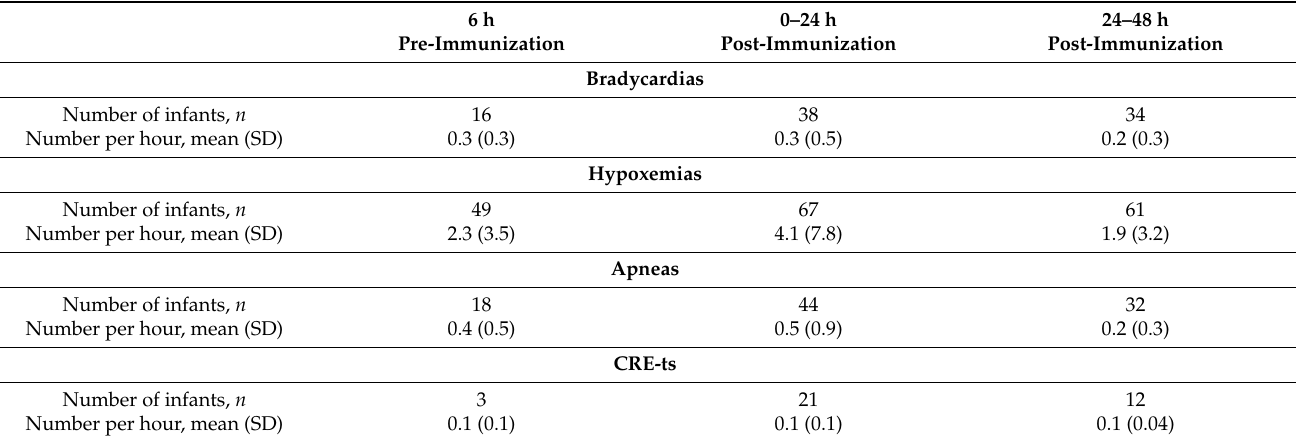
Table 3. Number of CREs per hour only in infants that presented with the respective